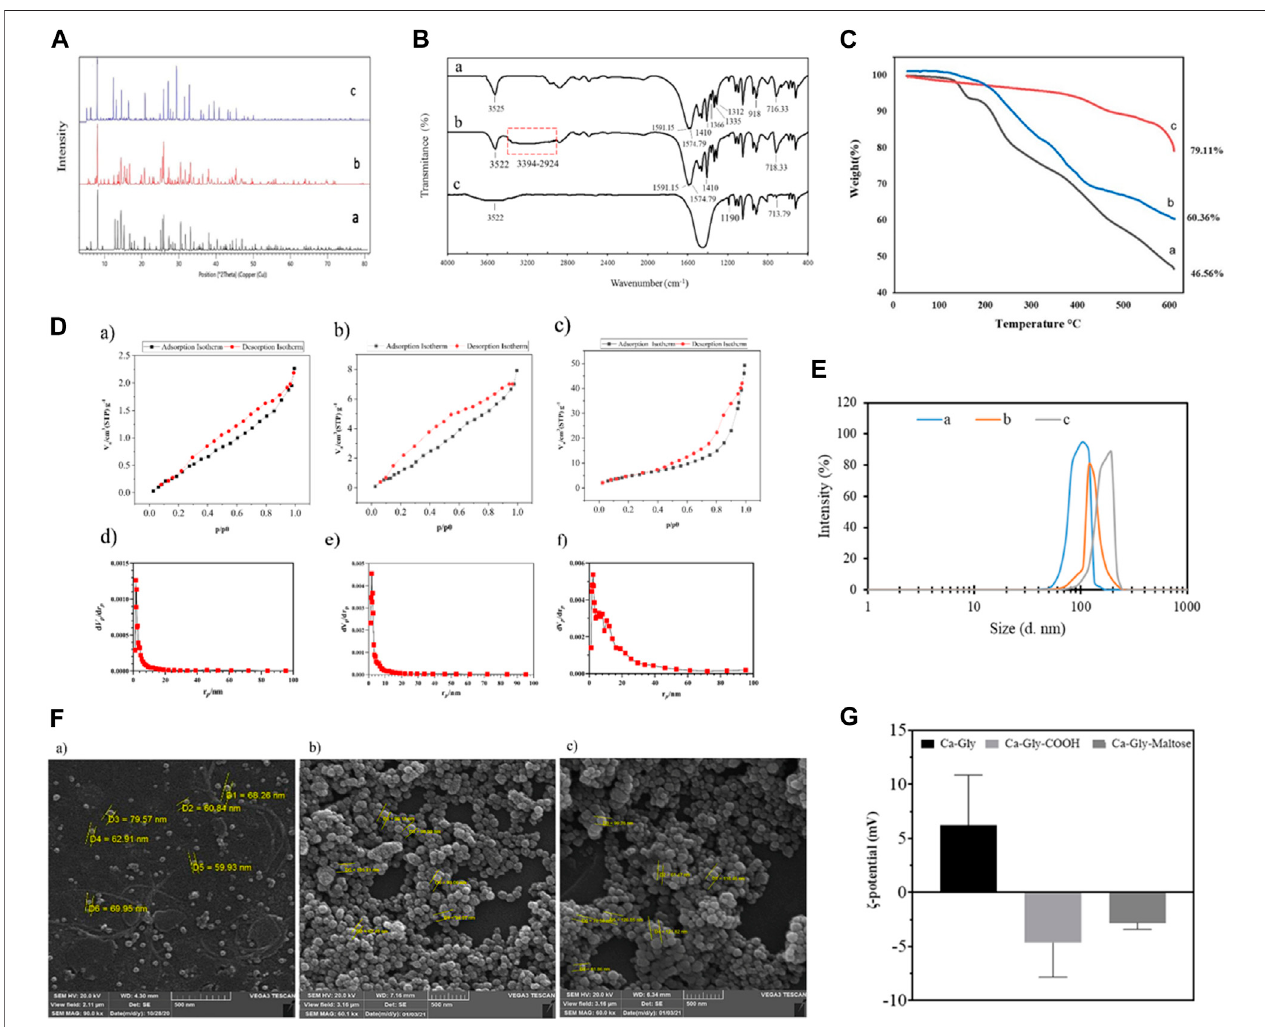
FIGURE 2 | (A) XRD Pattern, (B) FTIR spectra, (C) TGA analysis, (D) N2 adsorption isotherm at 77 K of a) Ca-Gly, b) Ca-Gly-COOH, c) and Ca-Gly-Maltose after outgassing at 150 ° C; and BJH pore volume distribution curves of d) Ca-Gly, e) Ca-Gly-COOH, f) and Ca-Gly-Maltose , (E) Hydrodynamic size distributions, (F) Zeta potential and (G) SEM images of a) Ca-Gly, b) Ca-Gly-COOH, c) and Ca-Gly-Maltose.